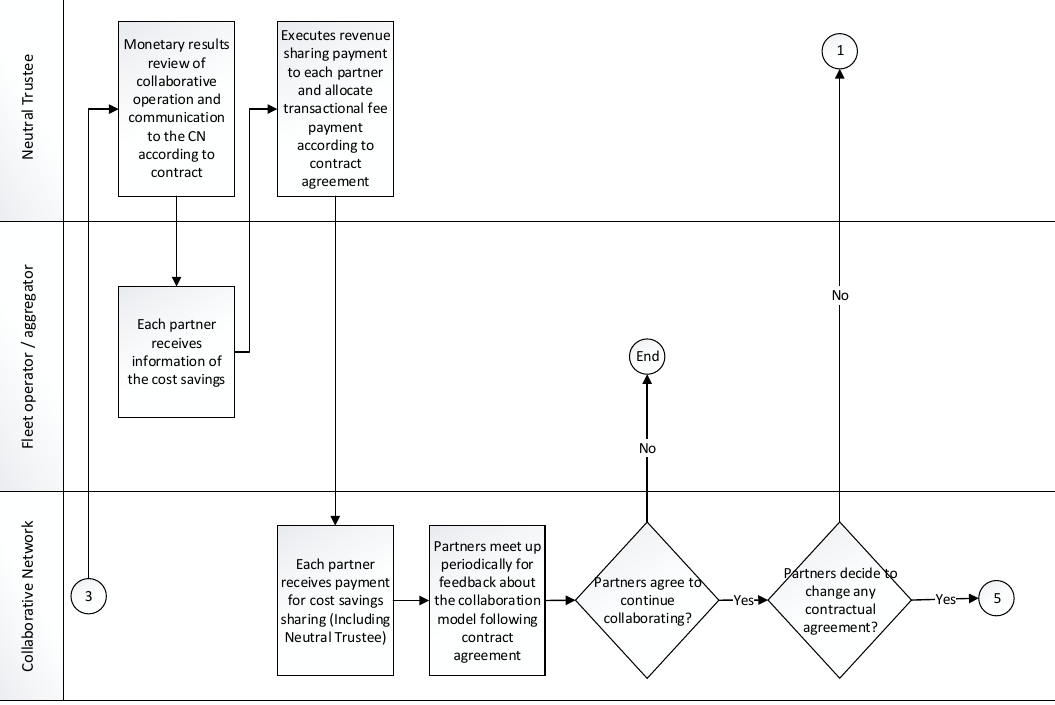
Figure 14. Workflow for proposed FSL business model—Results measure, Revenue sharing execution and Feedback.